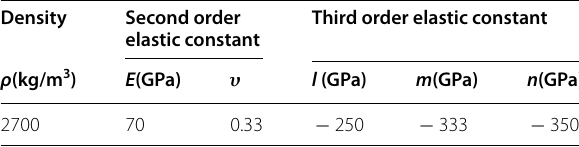
Table 1 Properties of nonlinear elastic materials Density